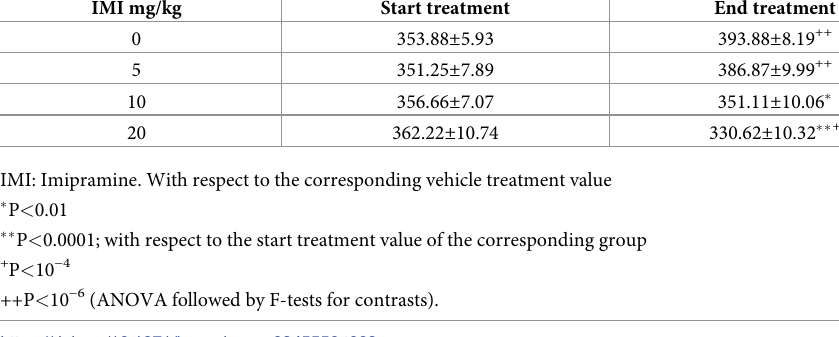
Table 2. Body weights.